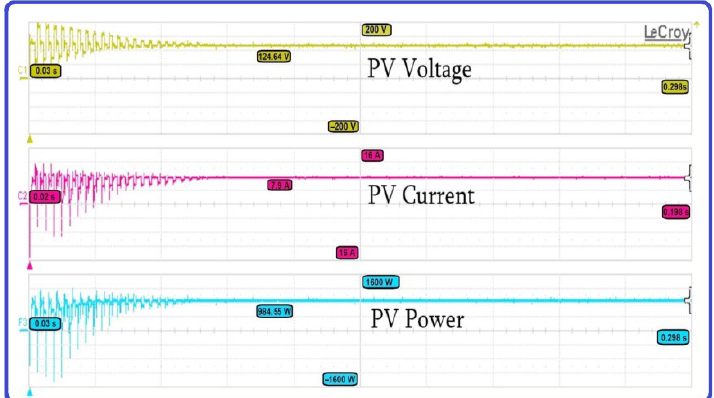
Figure 13. Experimental results of MPA technique for case 1.